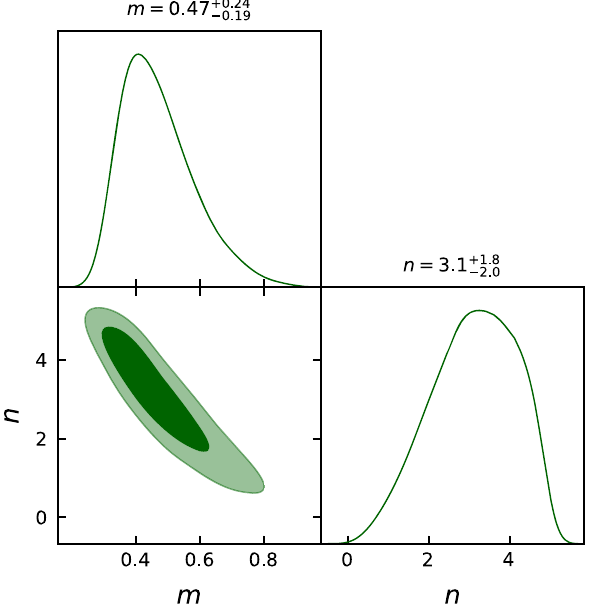
Fig. 3 The plot showing the best fit values of the model parameters m and n obtained with 1048 points of Pantheon datasets at 1 − σ and 2 − σ confidence level with b = 0